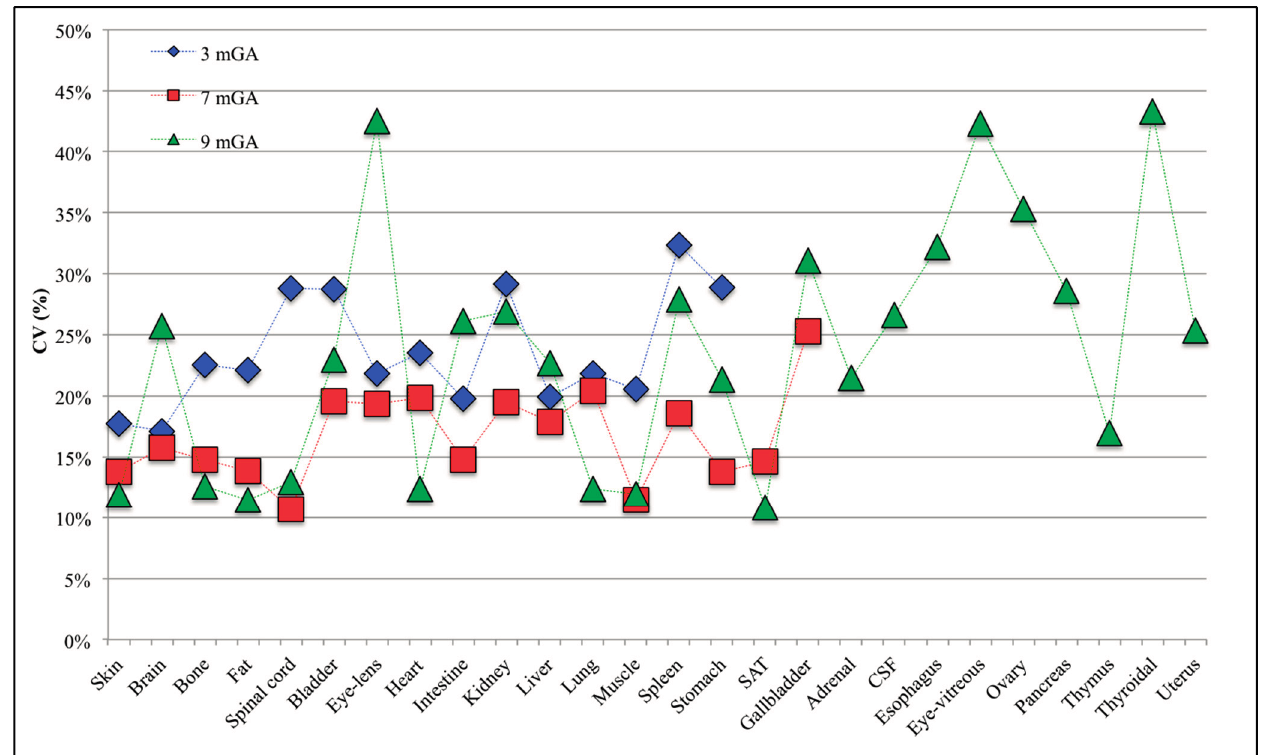
Figure 4. Coefficient of variation (CV) for each fetal tissue at 3, 7 and 9 months